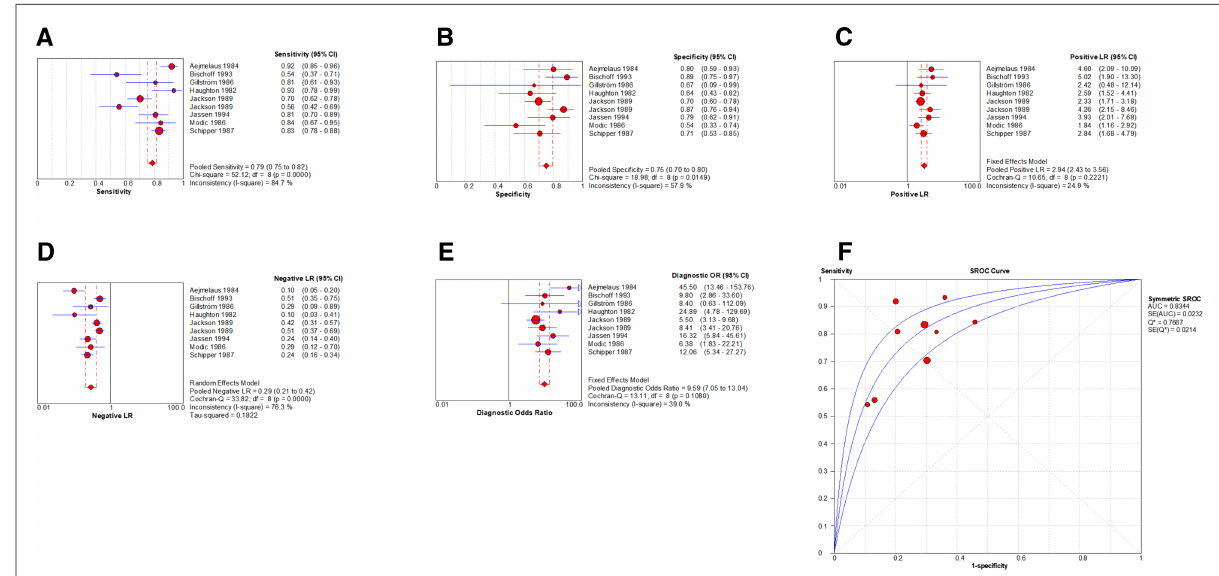
Figure 10 Forest plot of myelography for the diagnosis of LDH. The subgraph of ( A – F ) refers to Sen, Spe, +LR, − LR, DOR, AUC and Q*, respecti v